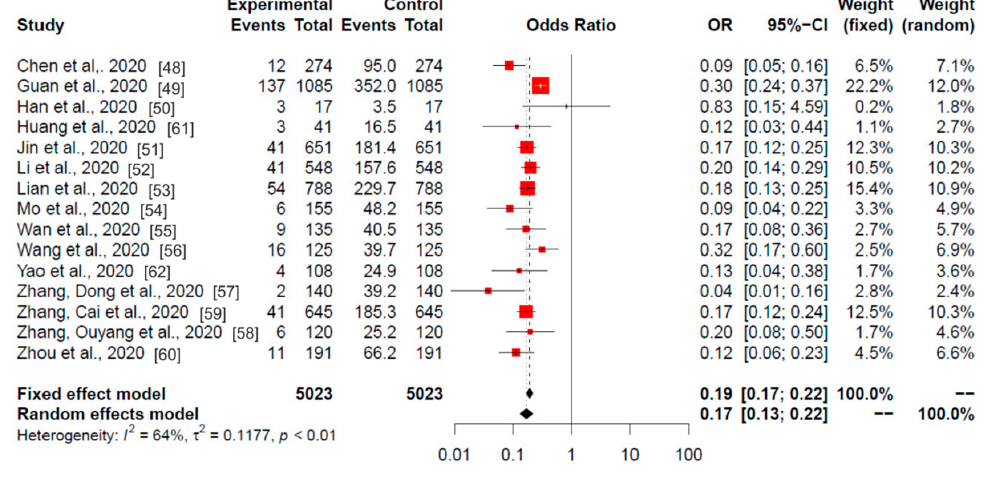
Figure 2. Meta-analysis of the Chinese studies. Odds ratios of the current smokers (experimental) among the hospitalised (control) patients with COVID-19 are shown. Data are from 15 published studies from the China outbreak. Red squares area is proportional to the size of the sample data. Black crosses and horizontal lines represent OR and 95% CI, respectively.